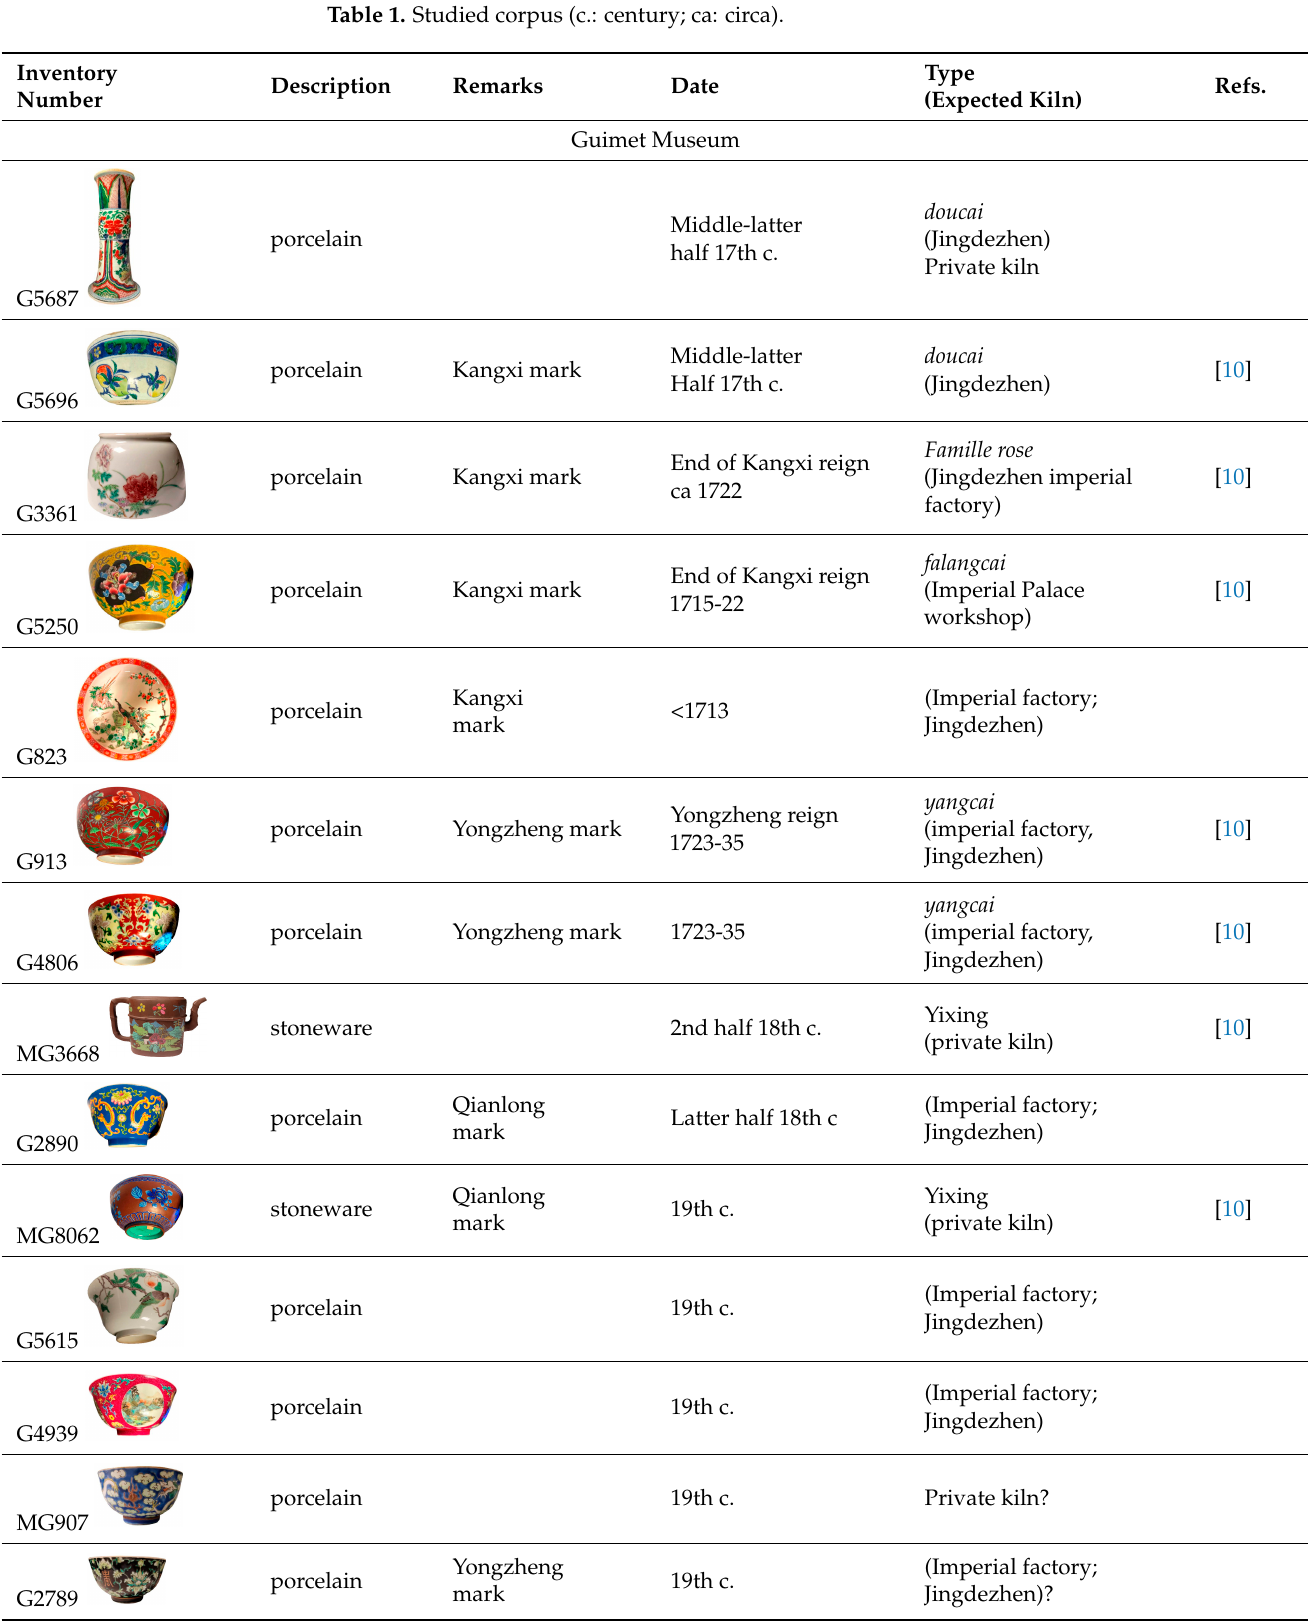
Table 1. Studied corpus (c.: century; ca: circa).